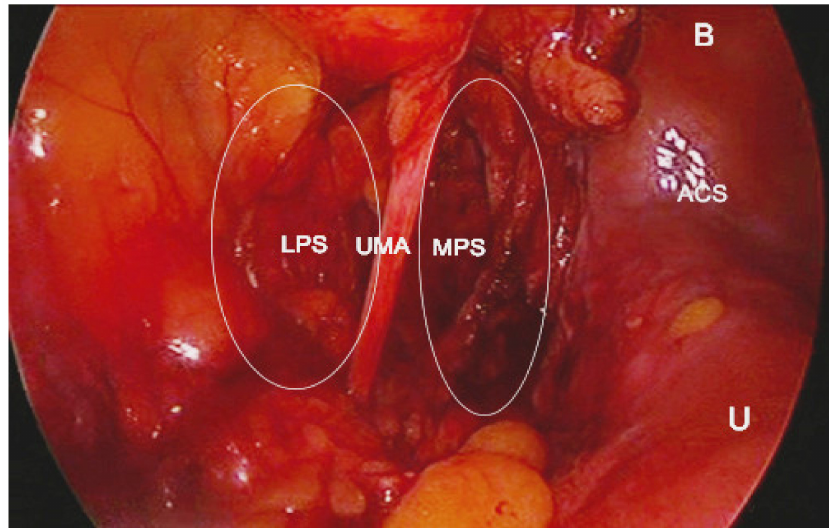
Figure 3. Paravesical space developed by laparoscopy (left side of the pelvis). MPS—medial paravesical space; LPS—lateral paravesical space; UMA—obliterated umbilical artery; U—uterus; B—bladder; ACS—anterior cul-de